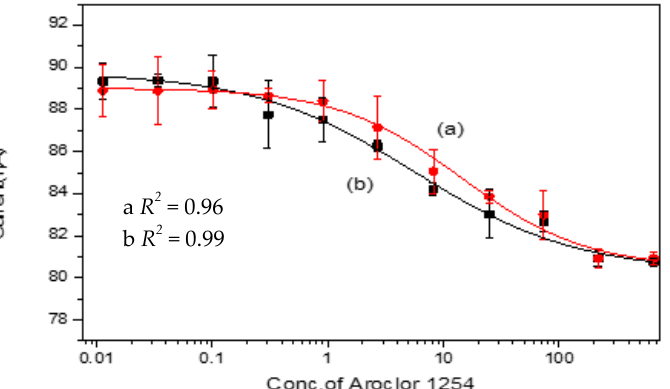
Figure 6. A competitive assay was conducted in which the performance of the gold electrode modified with 11-MUA was compared with the assay performance using (a) a bare gold electrode and (b) SAM modification gold electrode. Table 5. Comparison with previously reported electrochemical PCB immunosensors with present work.